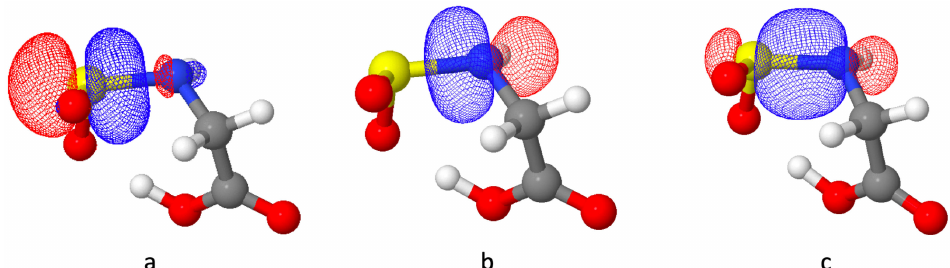
Figure 5. Localized molecular orbitals characterizing the N–S bond in the Gly derivative, P f . ( a , b ): Optimized atomic hybrids (LHOs) centered on S and N, respectively. ( c ): CLPO responsi- ble for the bond, where the LHO centered on N accounts for 0.64% of the linear combination.